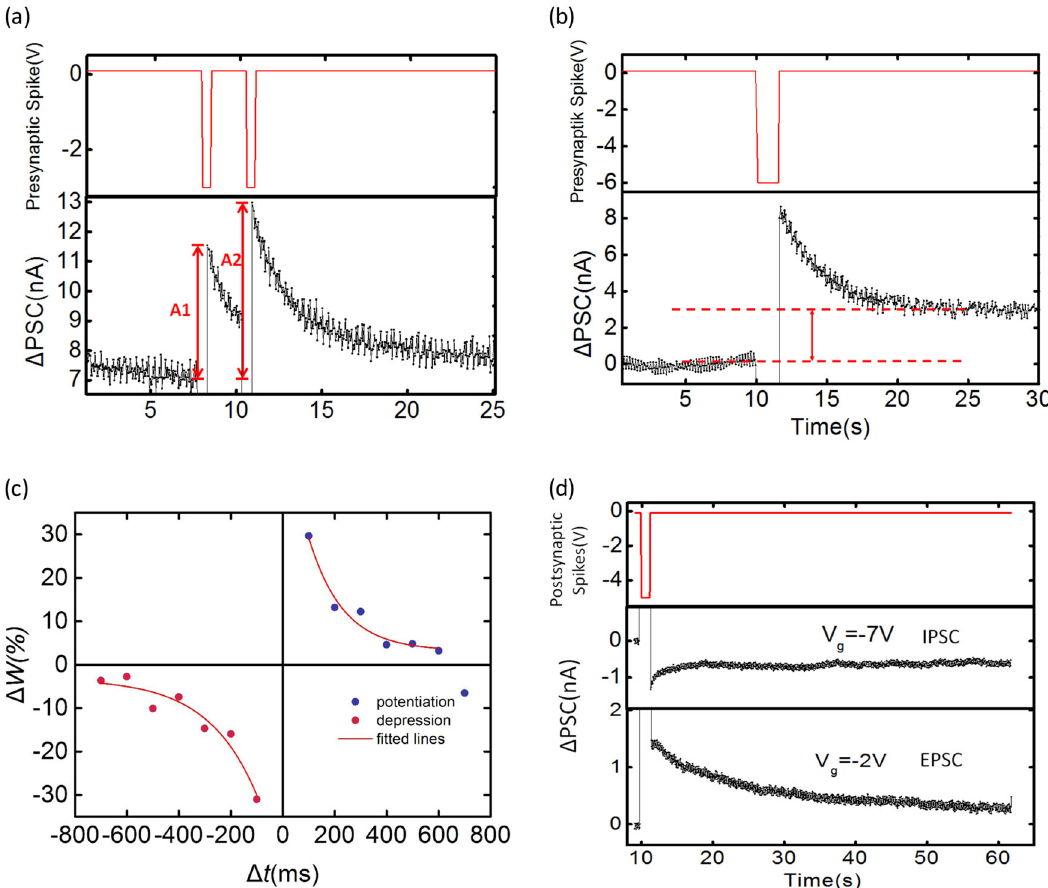
Fig. 4 Synaptic plasticity of the FMT. a PPF and (b) LTP in an arti fi cial synapse. A 100-mV reading voltage was applied before and after the spike to monitor the current change Δ PSC with the minimized effect induced by the reading voltage. c STDP follows the asymmetric Hebbian rule. d Excitatory synapses were achieved for V g = − 2 V, inducing an excitatory postsynaptic current (EPSC), while V g = − 7 V, inducing an inhibitory postsynaptic current (IPSC). Both Δ PSCs were induced by a presynaptic spike with − 5 V, 1 s. All data were tested on a device with L = 20 µm and W = 50